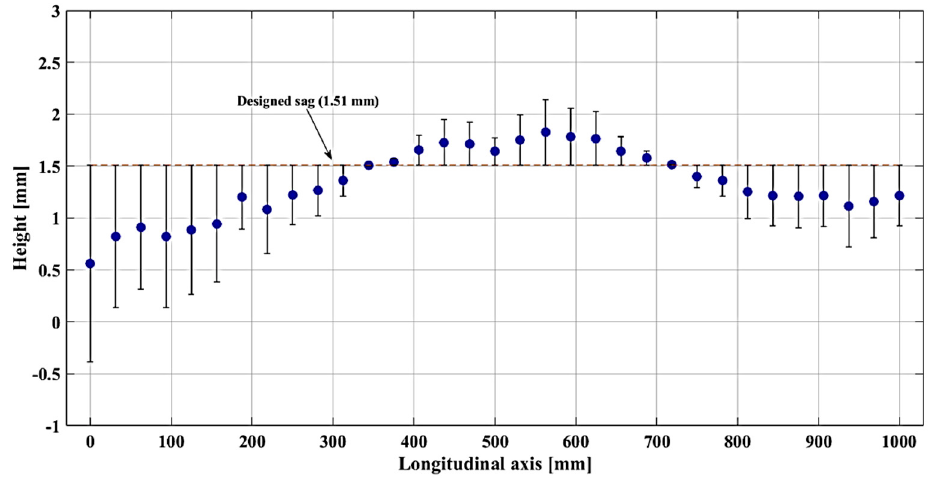
Figure 15. Deviation in millimeters of the calculated (measured) sag with respect to the sag of the designed geometry.